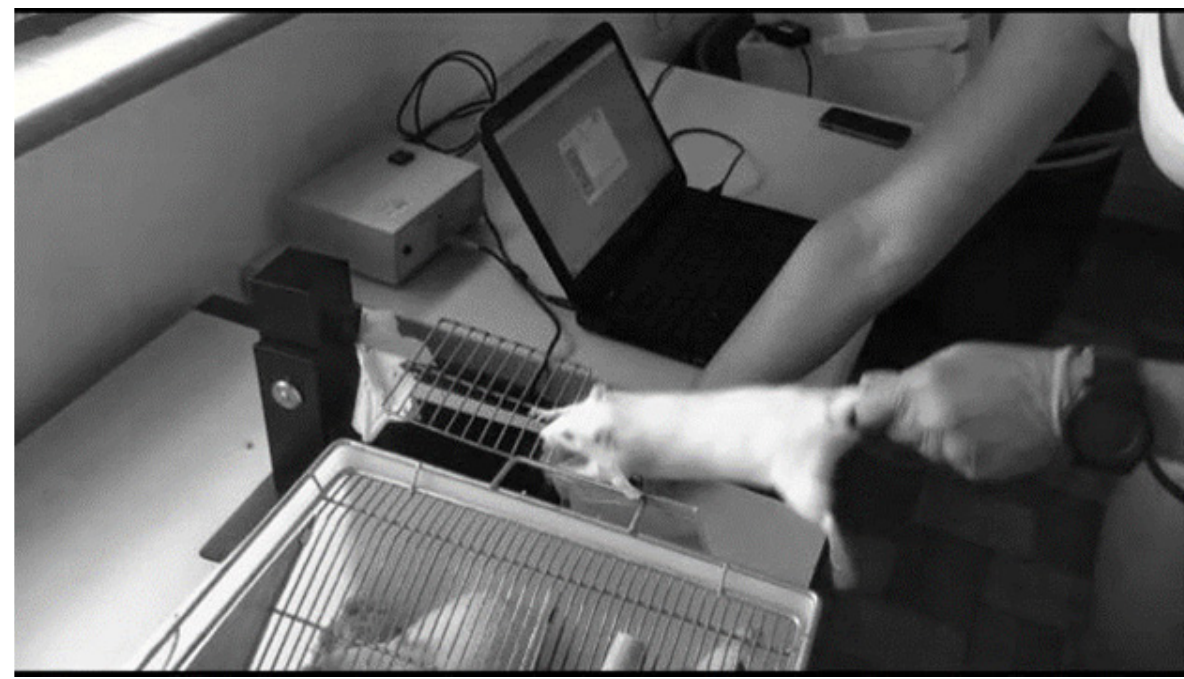
Figure 2. Manual grip strength